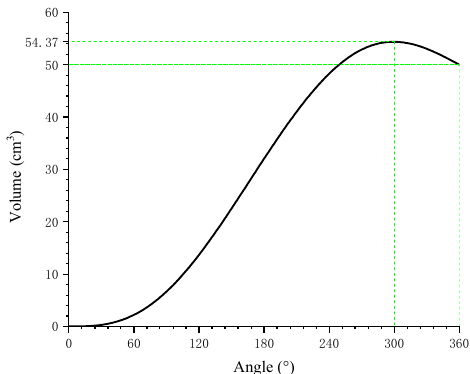
Figure 3. Variation of working chamber volume with rotation angle.